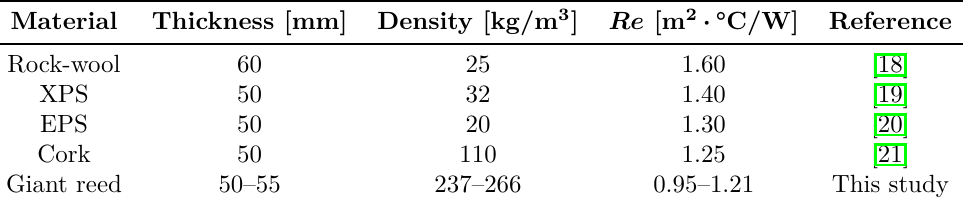
Table 3. Characteristics of the thermal insulation materials (adapted from